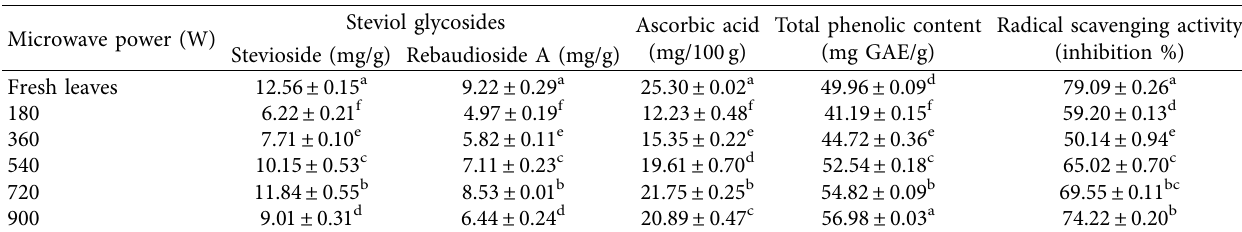
Values with same superscript letters in the same column are nonsignifcant at p < 0 . 05. Table 4: Variation in biochemical parameters of Stevia leaves dried at diferent levels of microwave power. Microwave power